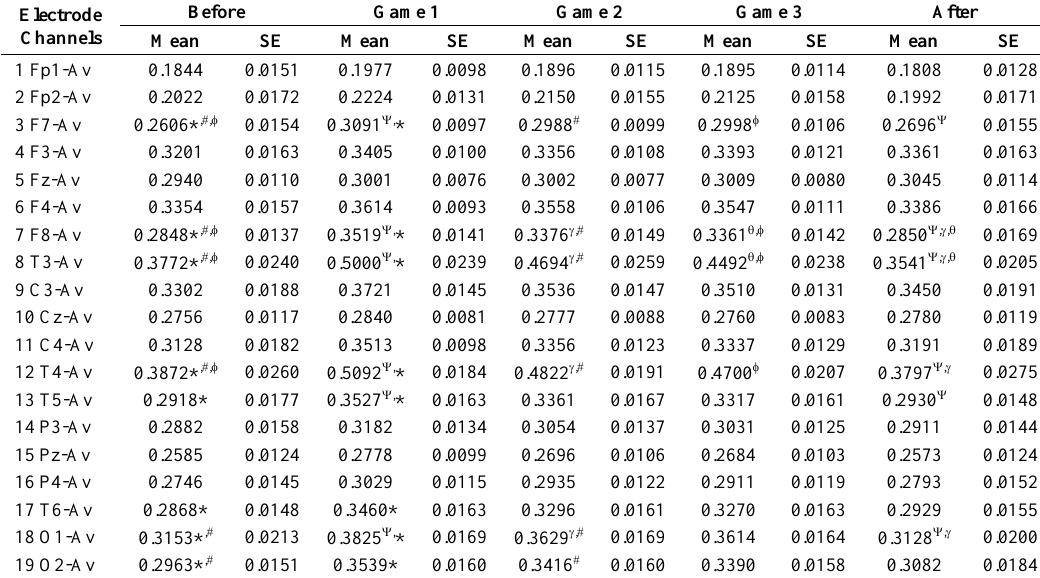
Table 6 Beta relative band powers between non-gameplays and during gameplays (*: before-game1,  : before-game2,  : before-game3,  : after-game1,  : after-game2,  : after-game3, p-value <